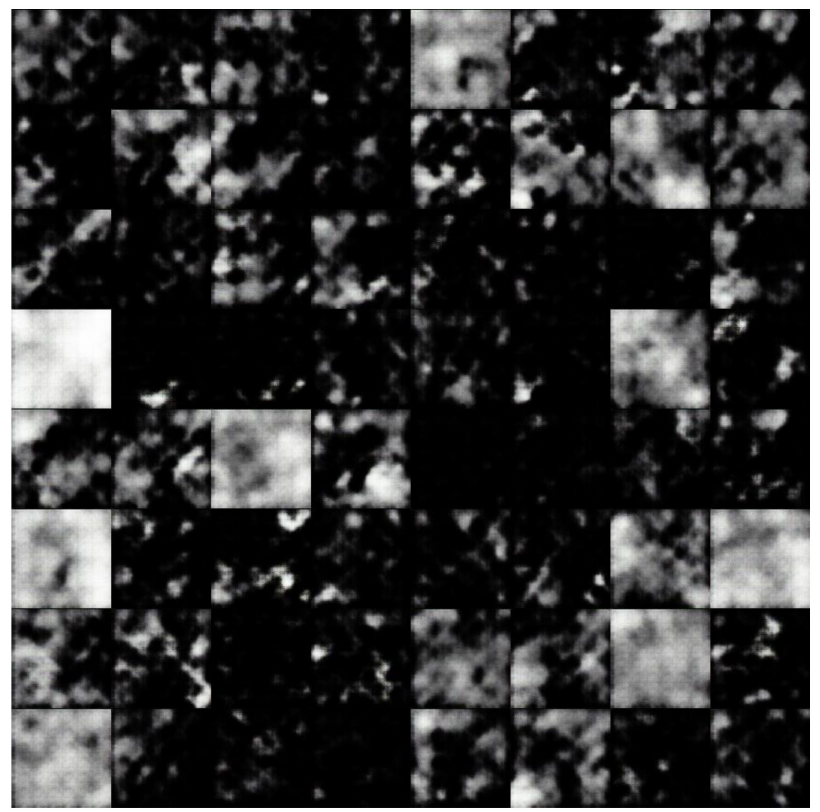
Figure 9. Greyscale results of people population density distribution generated by